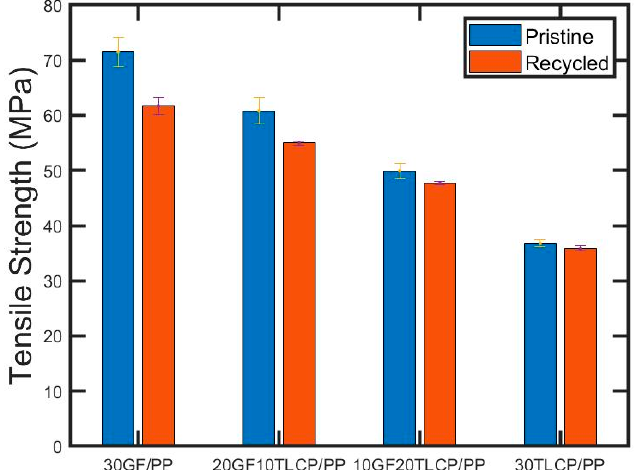
Figure 8. Tensile strength of pristine and recycled hybrid composites in the flow direction.